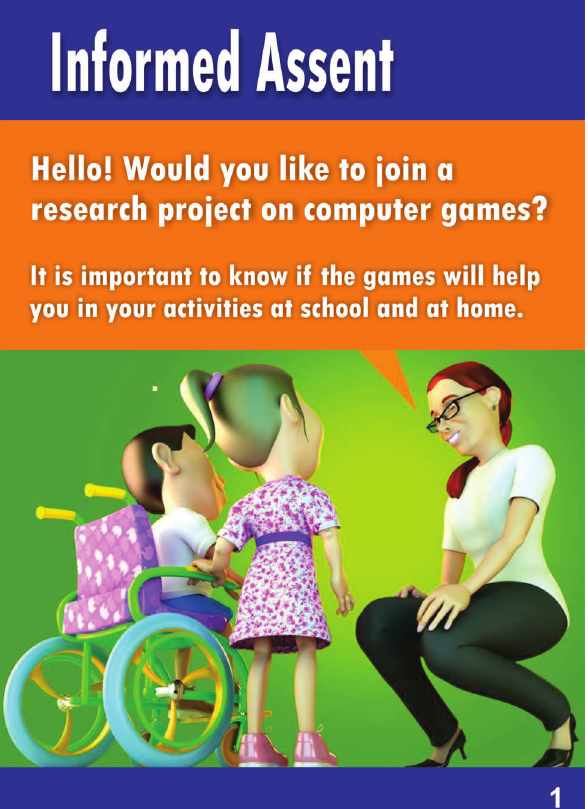
Figure 3B - Model of assent - Part